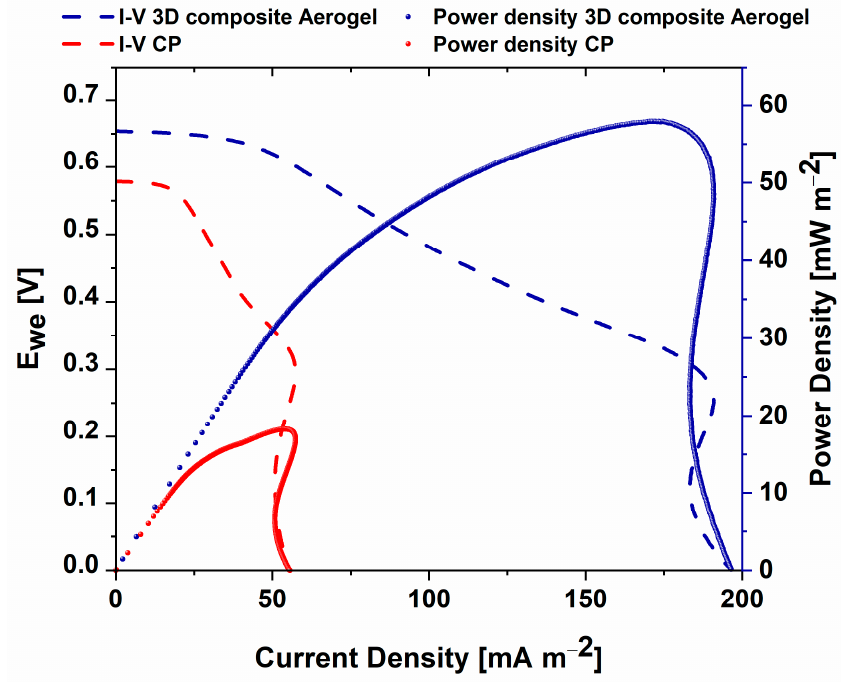
Figure 5. Linear sweep voltammetry curves obtained for 3D composite aerogels and for the reference anode electrode. Blue dot and dash represent, respectively, power density and I–V trend for 3D- composite aerogel , while red dot and dash report, respectively, power density and I–V trend for carbon-based material.